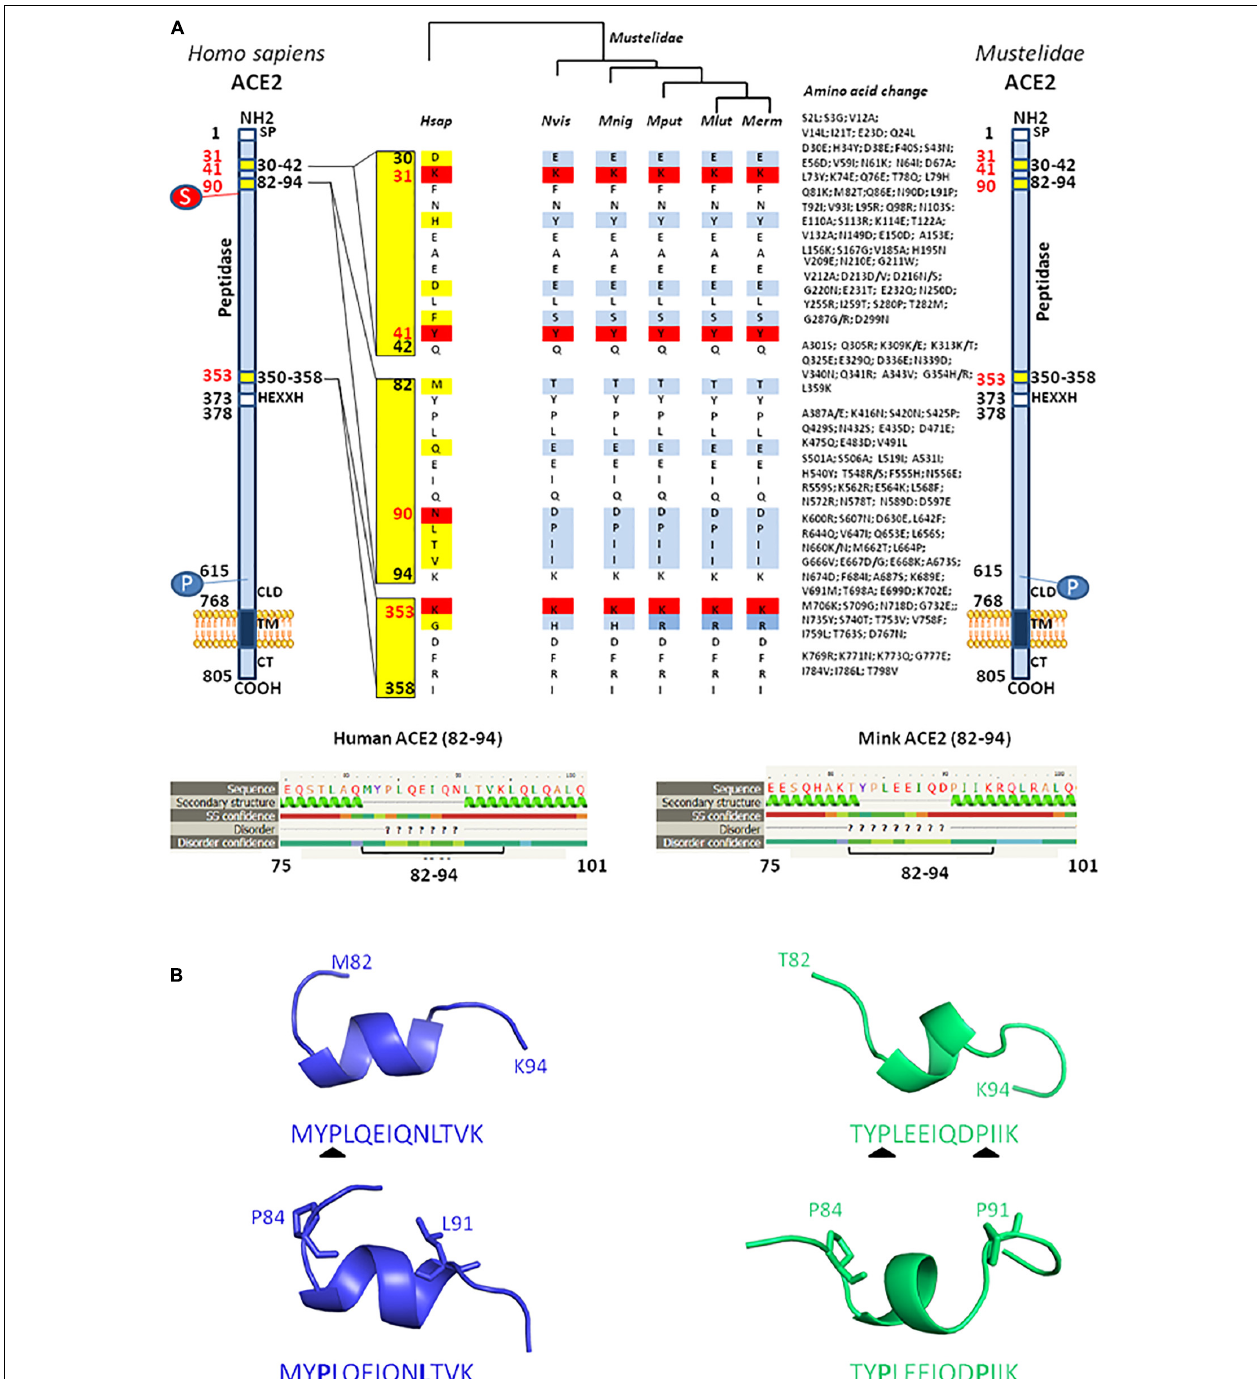
FIGURE 5 | Comparison between H. sapiens and different Mustelidae ACE2 proteins. (A) A schematic representation of the cell surface of the Hsap ACE2 molecule and its major domains is shown on the left side of the figure while the representation of the Mustelidae ACE2 is displayed on the right side of the figure. Amino acid changes compared to the human sequence are listed. The amino acid position is shown in black. The most important amino acids for SARS-CoV-2 interaction are in red. S, sugar; P, phosphorylation. The comparison of the H. sapiens (Hsap) ACE2 with five different ACE2 sequences from Mustelidae , i.e., N. vison (Nvis), M. nigripes (Mnig), M. putorius furo (Mput), M. lutreola (Mlut), M. erminea (Merm) was performed using Clustal Omega. The figure illustrates the homology (white or red) and difference (light blue or deep blue when there is a difference in amino acid usage between Mustelidae ) in the three regions (30–42, 82–94, and 353–358) involved in SARS-CoV-2 binding (middle panel). (B) Local prediction of the 82–94 amino acids peptide secondary structure using the Phyre2 server and three-dimensional folding using PeP-FOLD algorithm.